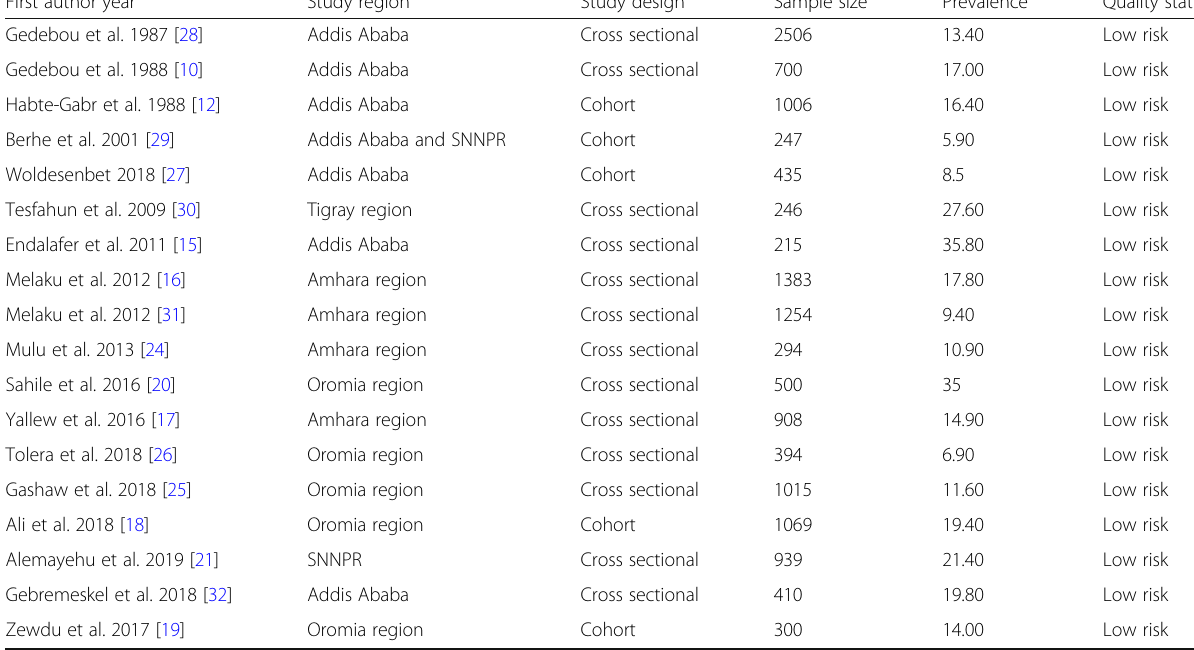
Table 1 Characteristics and quality status of the studies in the meta-analysis of